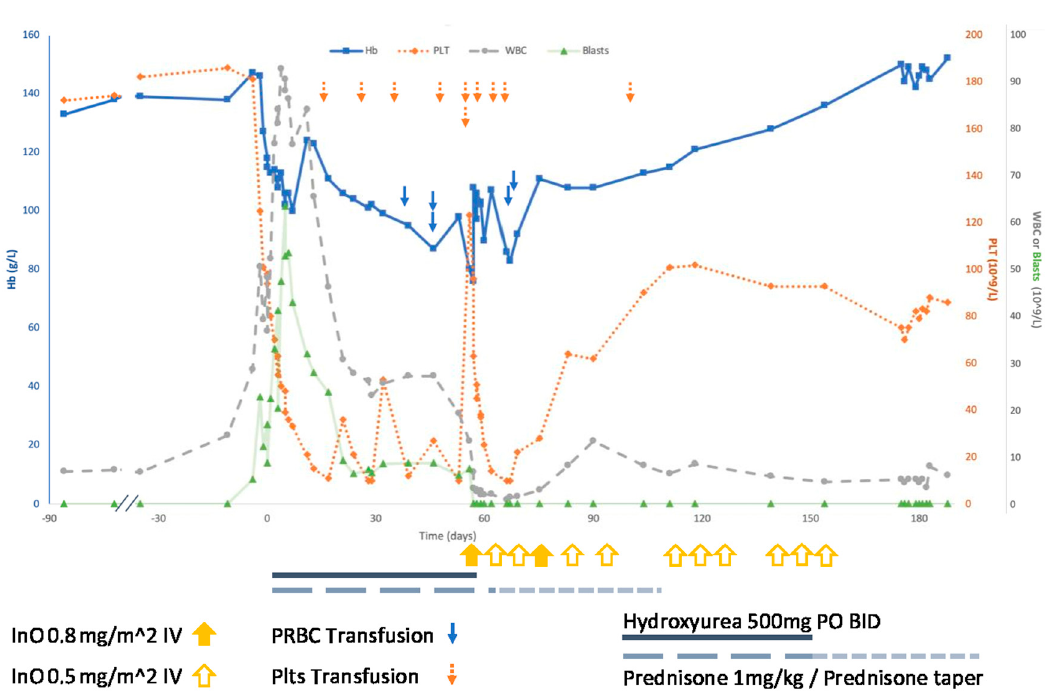
Figure 2. Serum hemoglobin (in g / L, primary y axis, squares with thick solid trend line), platelets (in platelets × 10 9 / L, secondary y axis, diamonds with dotted trend line), and white blood cells or blasts (in cells × 10 9 / L, tertiary y axis, white blood cells as circles with dashed trend line and blasts as triangles with thin solid line) shown longitudinally over time (days following diagnosis of relapse) for the outlined patient case. Treatments with (1) inotuzumab ozogamicin (InO) are shown as upward facing arrows along the x axis (solid: 0.8 mg / m 2 ; hollow: 0.5 mg / m 2 ); (2) hydroxyurea (500 mg PO BID) are shown below the x -axis as a solid black line); and (3) prednisone are shown below the x -axis as dashed grey line (large dashes: 1 mg / kg; small dashes: taper to o ff ). Packed red blood cell transfusions are shown along the HB trend line as solid downward facing arrows, and platelet transfusions are shown at the top the graph as dashed downward facing arrows. Note: the dose of platelets transfused on day + 105 was ordered without an indication.